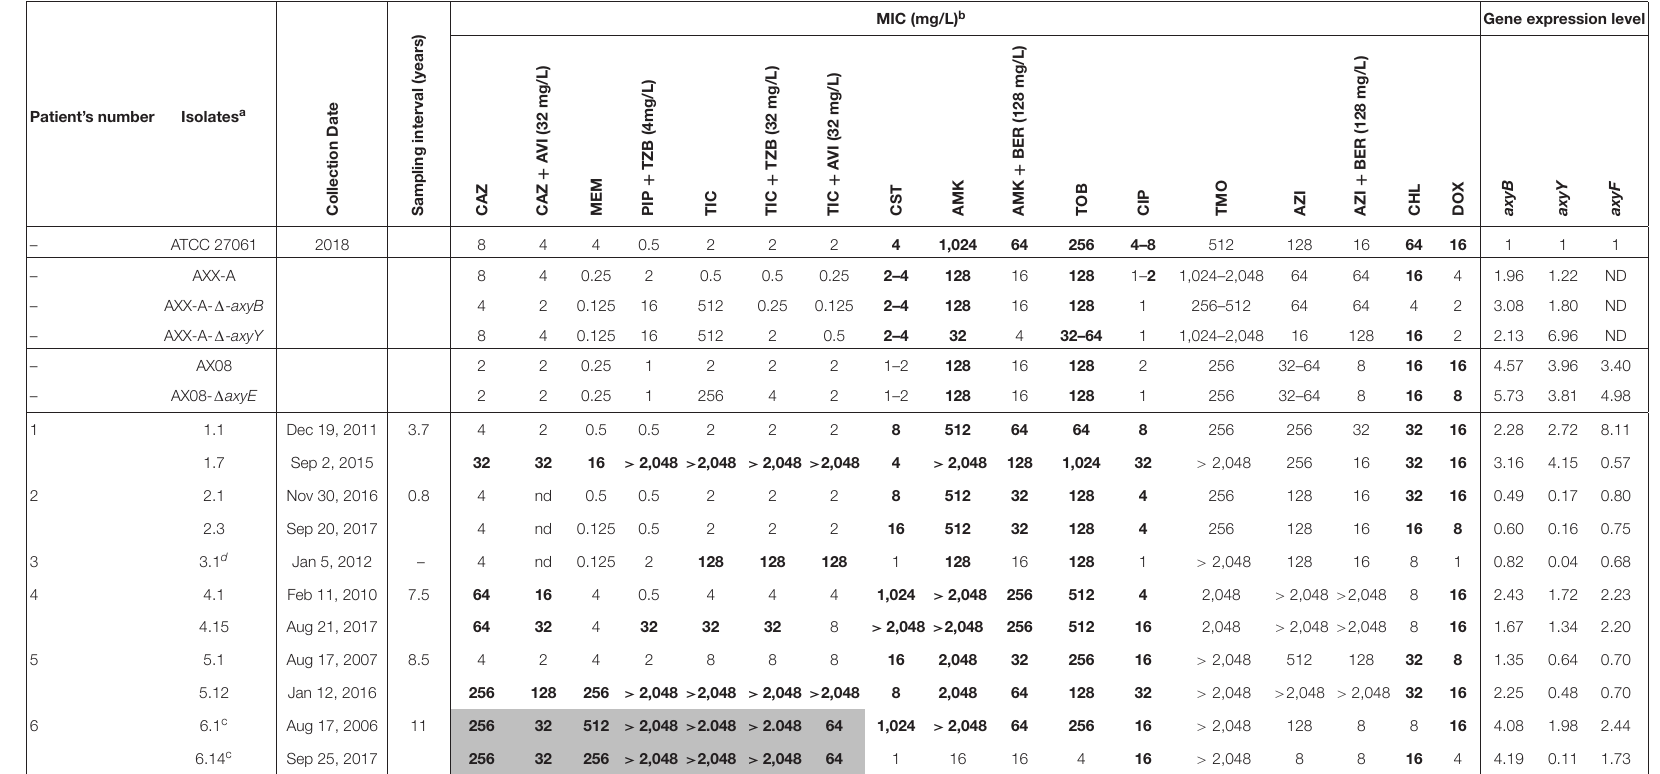
TABLE 1 | Individual MICs for the reference strains and the 41